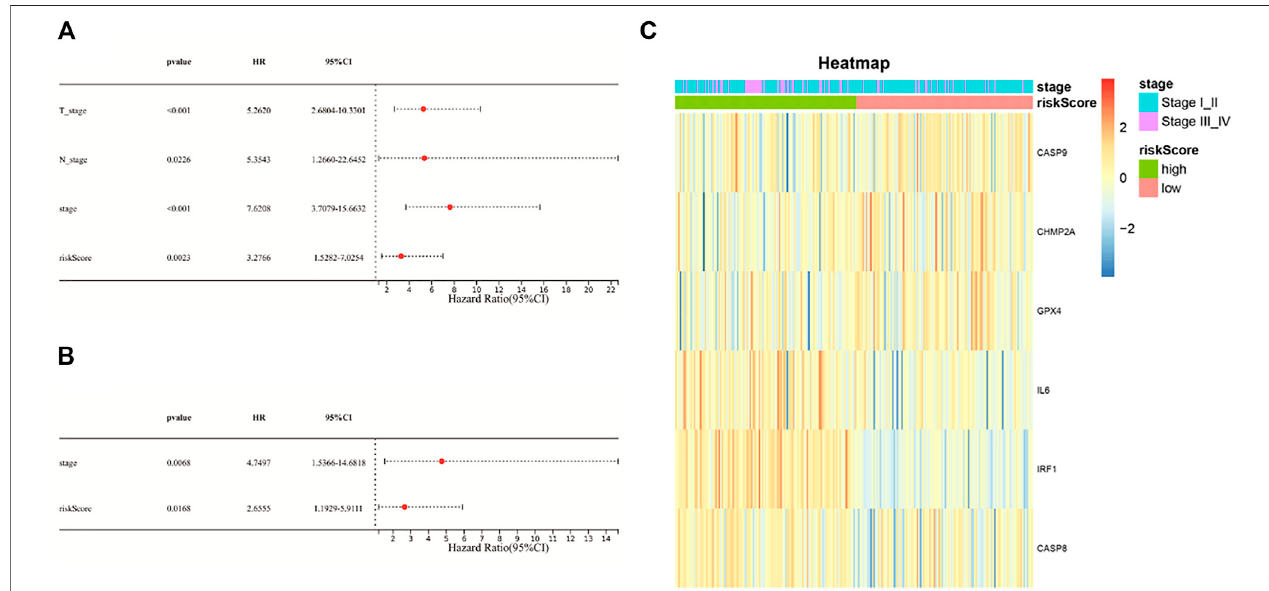
FIGURE 5 | (A – C) GO functional enrichment analysis of DEGs in the two risk groups (BP, biological process; CC, cellular component; MF, molecular function); (D) KEGG pathway analysis of DEGs in the two risk groups.